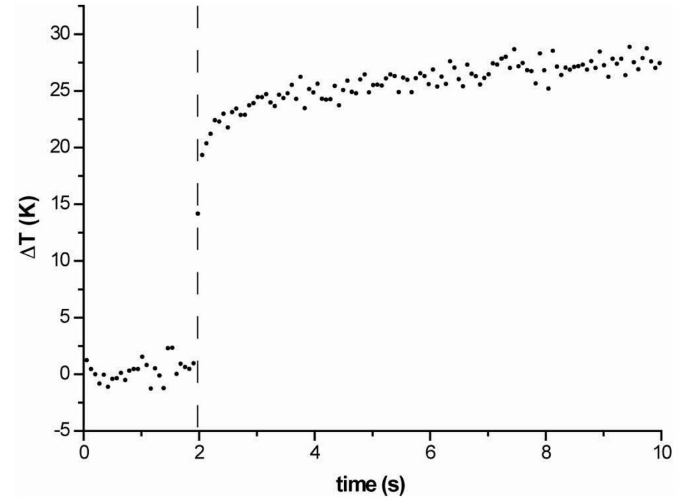
Figure 20. Temporal revolution of the temperature from the laser radiation in the optical stretcher. The laser is turned on at t = 2 s and has a total power of 2 W. Figure reproduced from Reference [71] with permission from Optical Society of